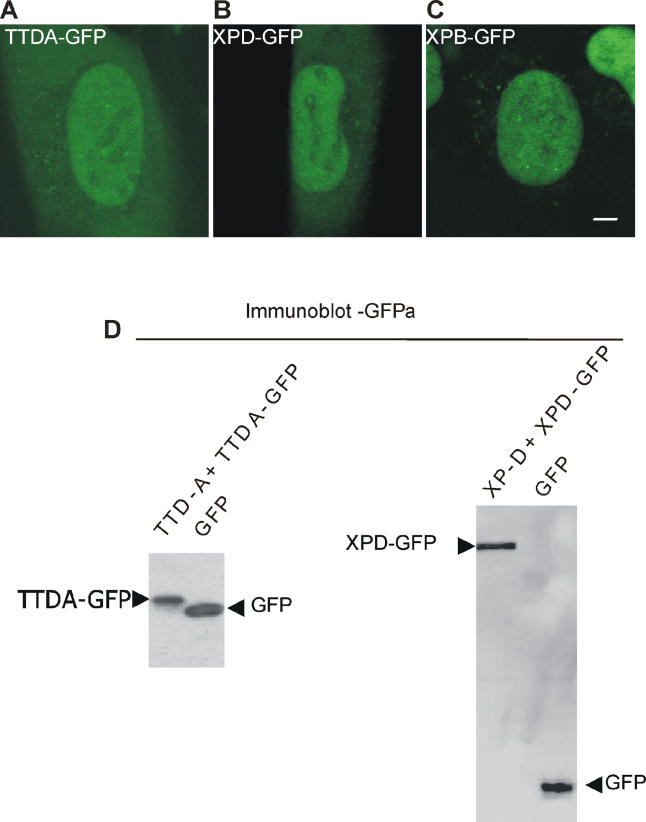
Localization of TTDA-GFP and XPD-GFP(A) Confocal image of a TTDA-GFP-expressing cell.(B) Confocal image of a XPD-GFP-expressing cell.(C) Confocal image of a XPB-GFP-expressing cell.(D) Immunoblot probed with anti-GFP monoclonal antibody of TTD1BRSV (TTD-A) fibroblasts stably expressing TTDA-GFP (lane 1), XP6BESV (XP-D) transformed fibroblasts stably expressing XPD-GFP (lane 3), and MRC5SV (wt) transformed fibroblasts expressing free GFP (lane 2 and 4).